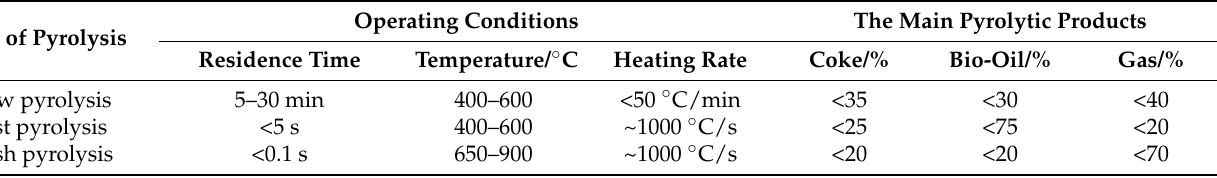
Table 4. The typical type of pyrolysis technology. Reprinted with permission from ref.